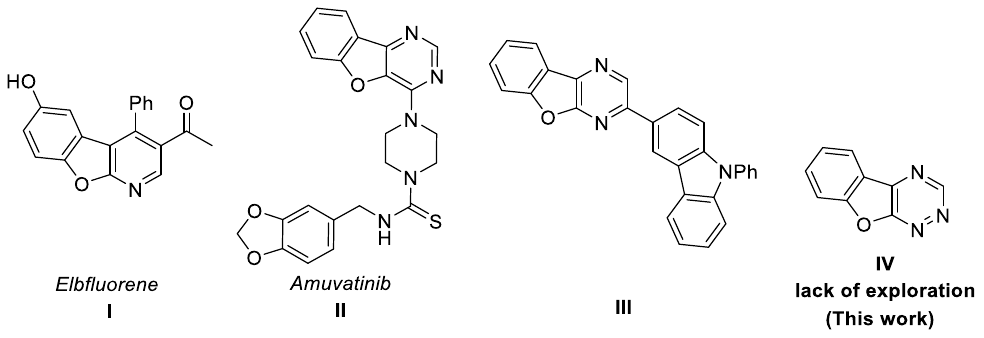
Figure 1. Representative benzofuro-fused N-heterocycles.